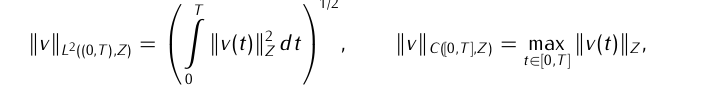
, 1 ≤ i ≤ 2 , and a boundary Γ out